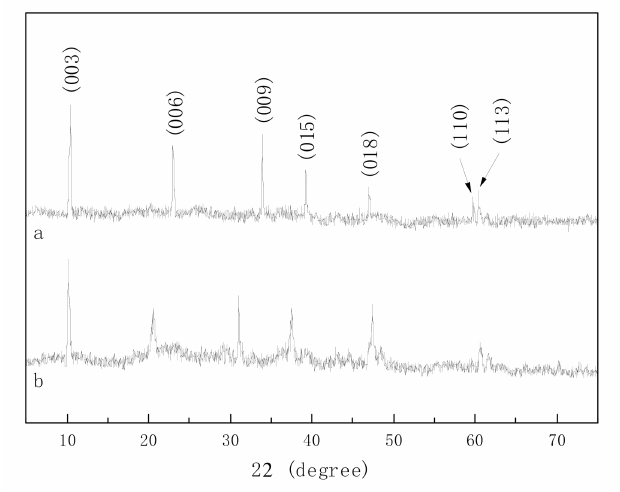
Figure 3. XRD patterns of pure hydrotalcites ( a ) and IL-CaMgAl ( b